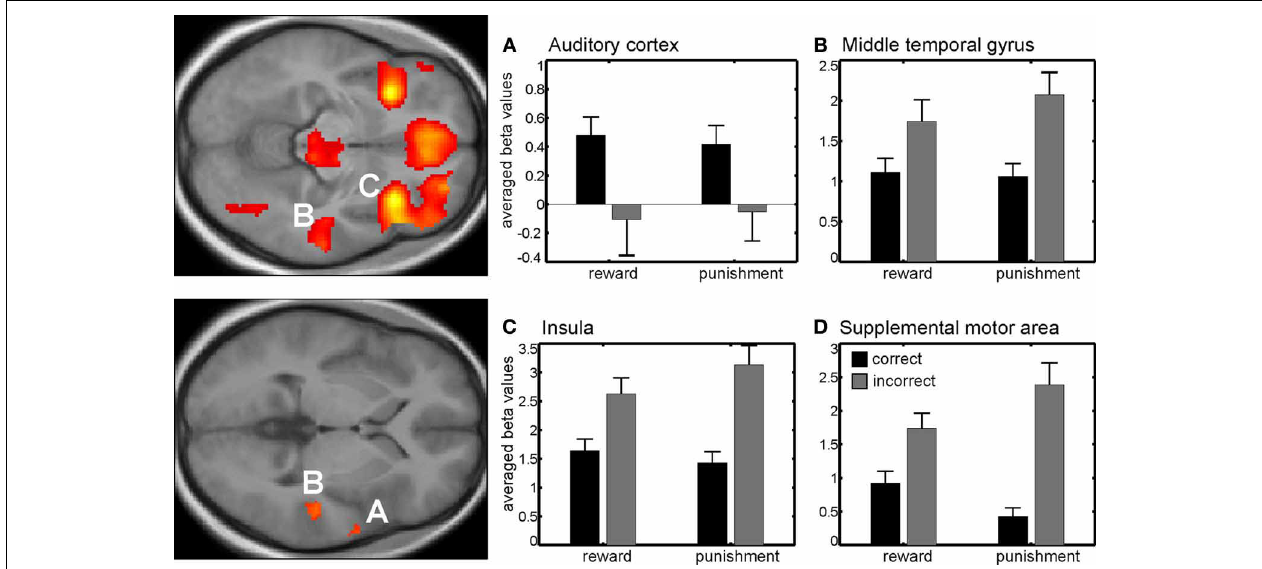
FIGURE 2 | Main effect of correctness. Beta values in right auditory cortex (A) show a higher neural activity for correct trials compared to incorrect trials. Other brain areas showing differential responses were the right middle temporal gyrus (B) , the right insula (C) , and the pre-supplemental motor area (D) among others. Note that here